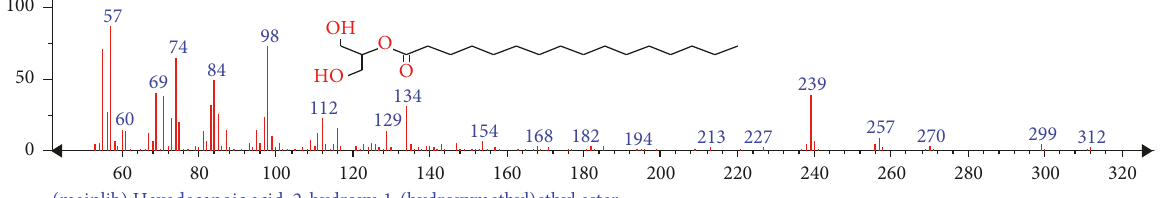
Figure 53: Mass spectrum of compound hexadecanoic acid, 2-hydroxy-1-(hydroxymethyl)ethyl ester of whole plant hexane fraction of Achillea wilhelmsii (WHFAW).